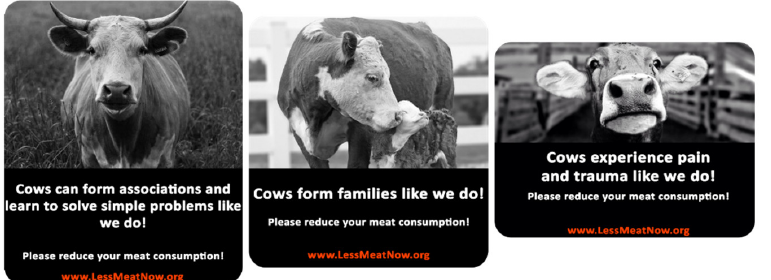
Figure 1. The three anthropomorphic stickers (Sticker 1: Intelligence anthropomorphism, sticker 2: Pro-social anthropomorphism, sticker 3: Pain anthropomorphism). Pro-social anthropomorphism, sticker 3: Pain